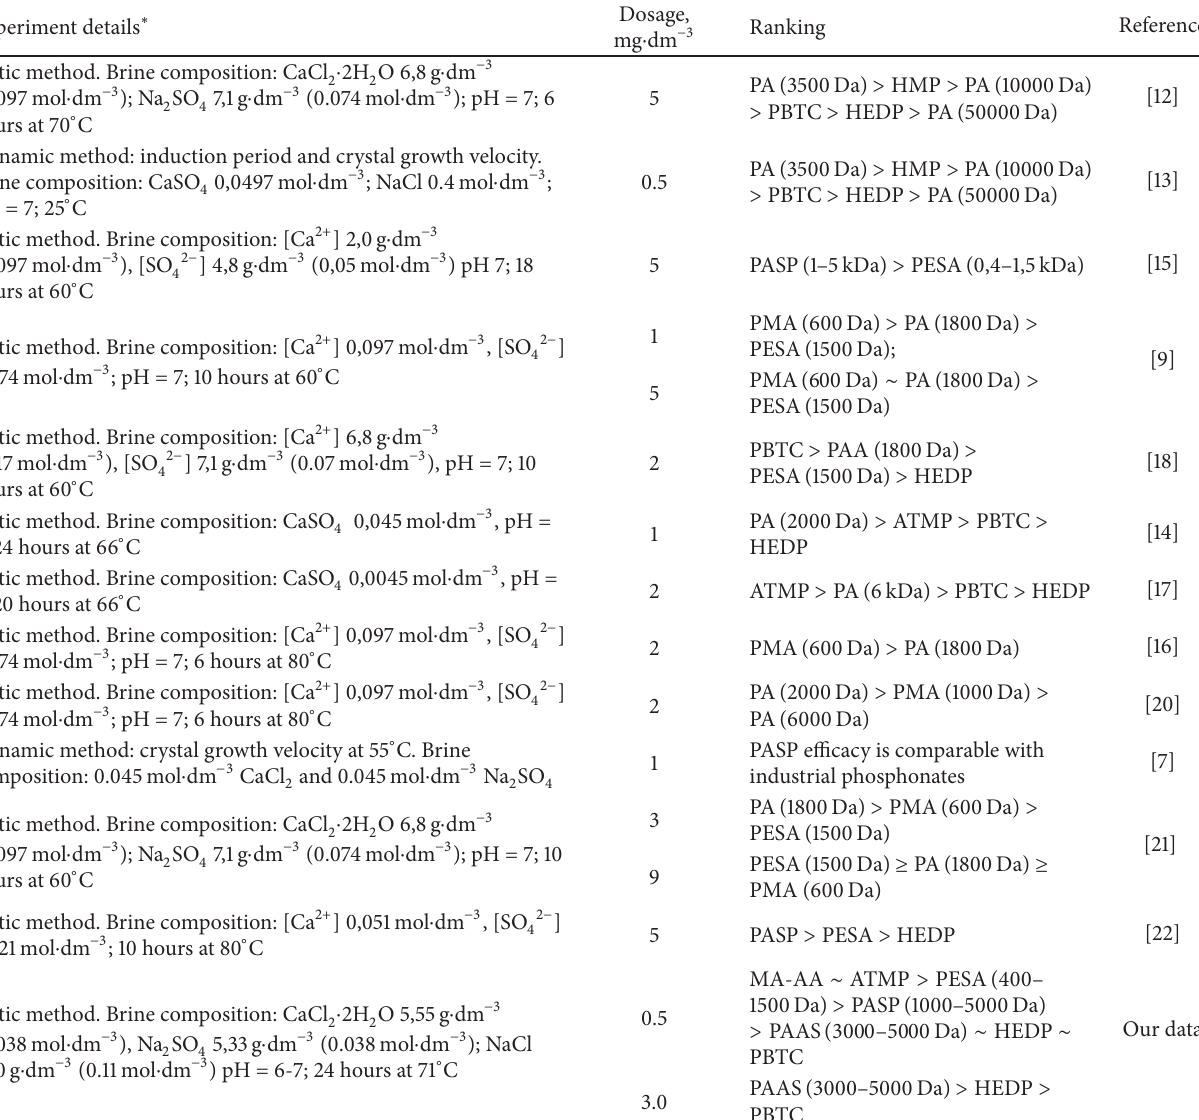
Table 3: Scale inhibitors ranking reports for calcium sulfate.